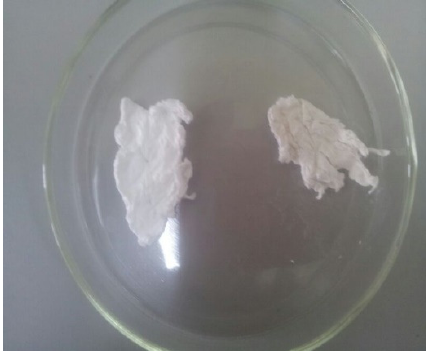
Fig. 2. The sample after treatment with Fenton's